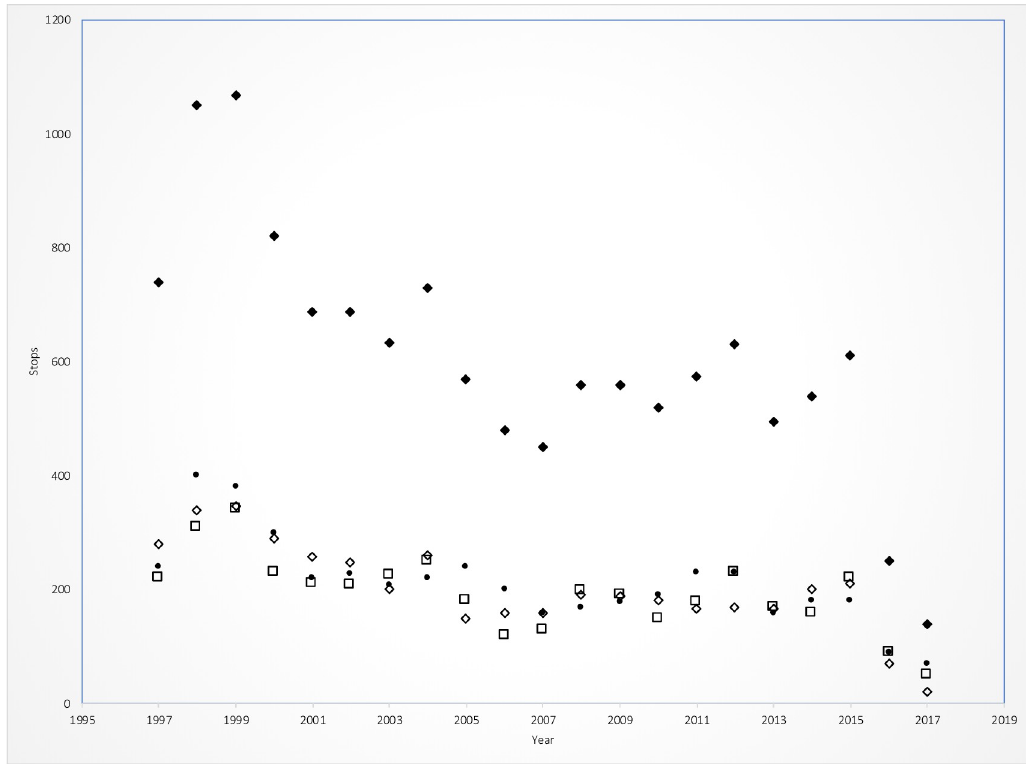
Fig 2. Number of LAMP stops visited, 1997 through 2017 by year and run. Key: solid-diamonds: sum of stops for year; solid- circles: Run 1 (winter); open-squares: Run 2 (Spring); open-diamonds: Run 3 (Summer).